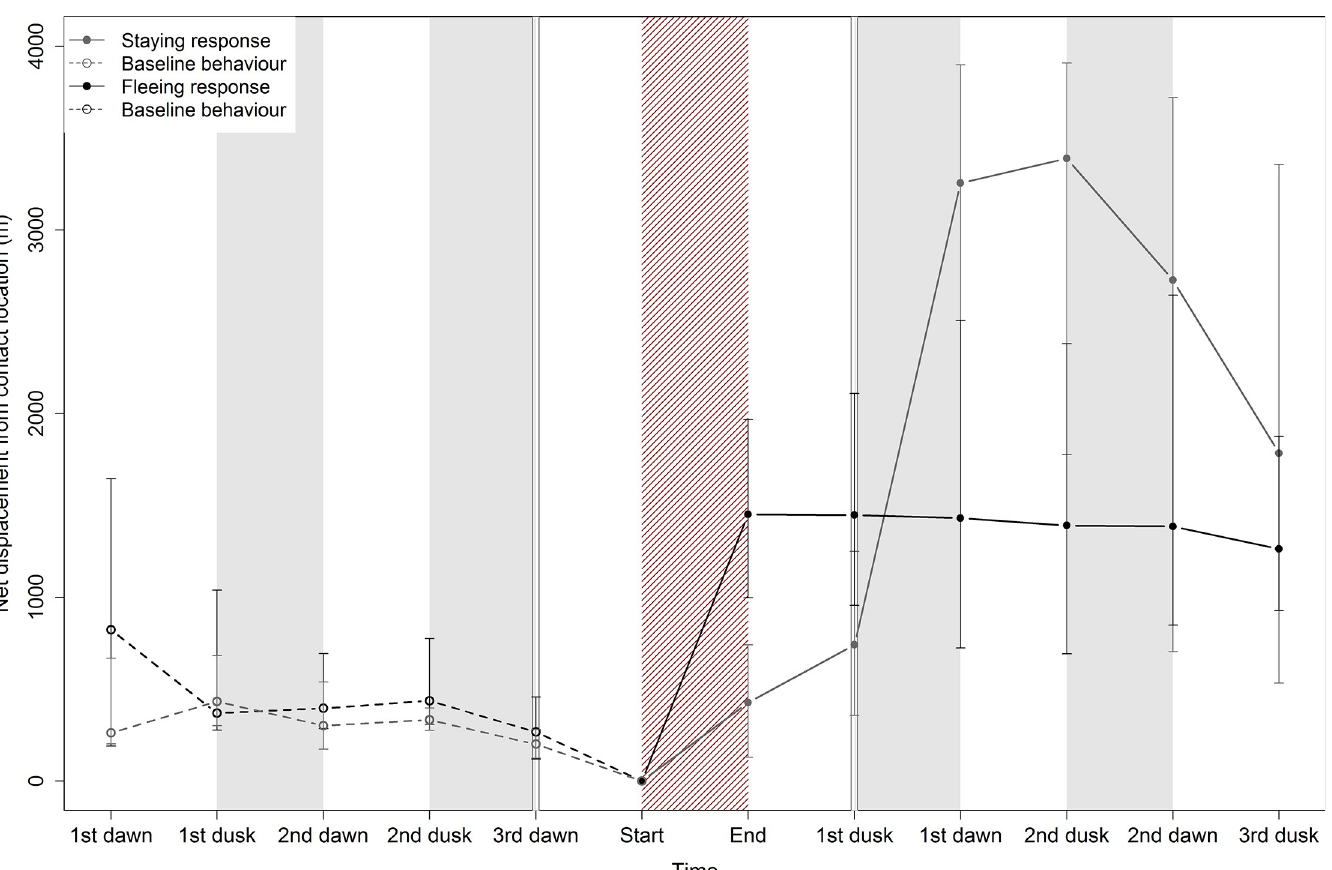
Fig 3. Median net displacement of red deer from the encounter site with hunters ( i . e . distance from the location of the monitored individual at the beginning of the drive hunt) calculated over a five-day period in the National Estate of Chambord, France, 2016–2018. Two responses were distinguished during the immediate phase based on whether or not the individual crossed the shooting line and moved out of the hunted area during the drive hunt. The black line describes movement patterns of red deer ‘fleeing’ from the encounter site (n = 23), whereas the grey line describes these patterns for ‘remaining’ individuals (n = 12). Black dots correspond to responses following a contact with hunters, whereas white dots correspond to the baseline behaviour ( i . e . during the hunting season, but in the absence of hunters) of individuals. First and third quartiles are represented using vertical bars. The grey areas represent the night-time period. The red hatched area corresponds to the drive hunt period. The plot was divided into three panels in order to illustrate the non-continuous time scale: (1) one relocation every hour from 1 st dawn to 3 rd dawn, (2) one relocation every other minute from 3 rd dawn to 1 st dusk and (3) one relocation every hour from 1 st dusk to 3 rd dusk.